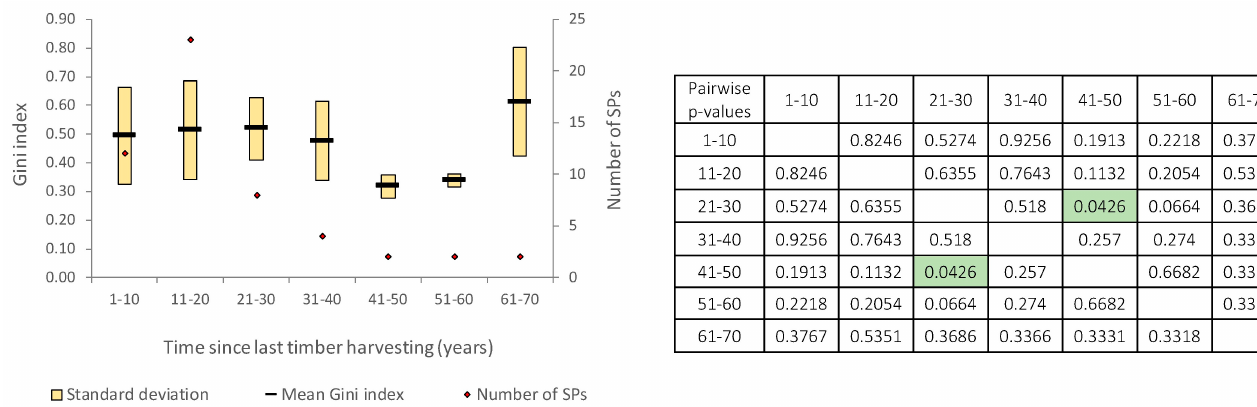
Figure 5. Trees’ dimensional heterogeneity on time classes since last timber harvesting (green color highlights the significant differences: p < 0.05).